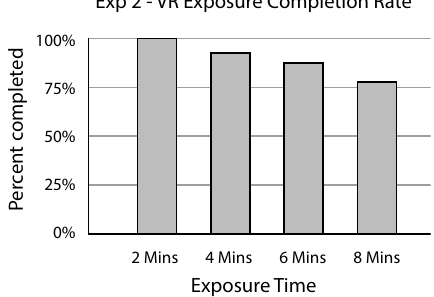
Fig. 8 Percent of subjects who completed each of the VR exposure blocks in Experiment 2. The procedure was stopped if subjects reported more than mild motion sickness symptoms (>6 on MISC scale). Over 75% of the subjects were able to complete the full 8 min of